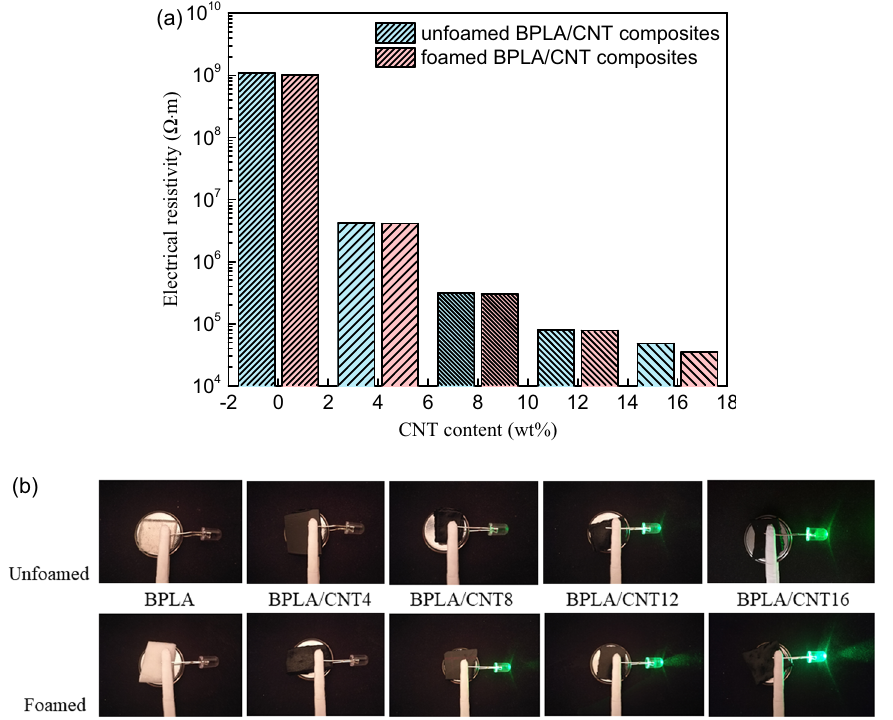
Figure 7: ( a ) Electrical resistivity of BPLA/CNT composite foamed and unfoamed in function of CNT content; ( b ) conductive e ff ect of BPLA/CNT foamed and unfoamed